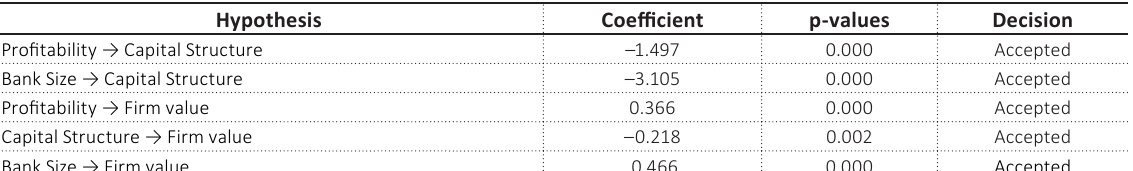
Table 4. Hypothesis assessment